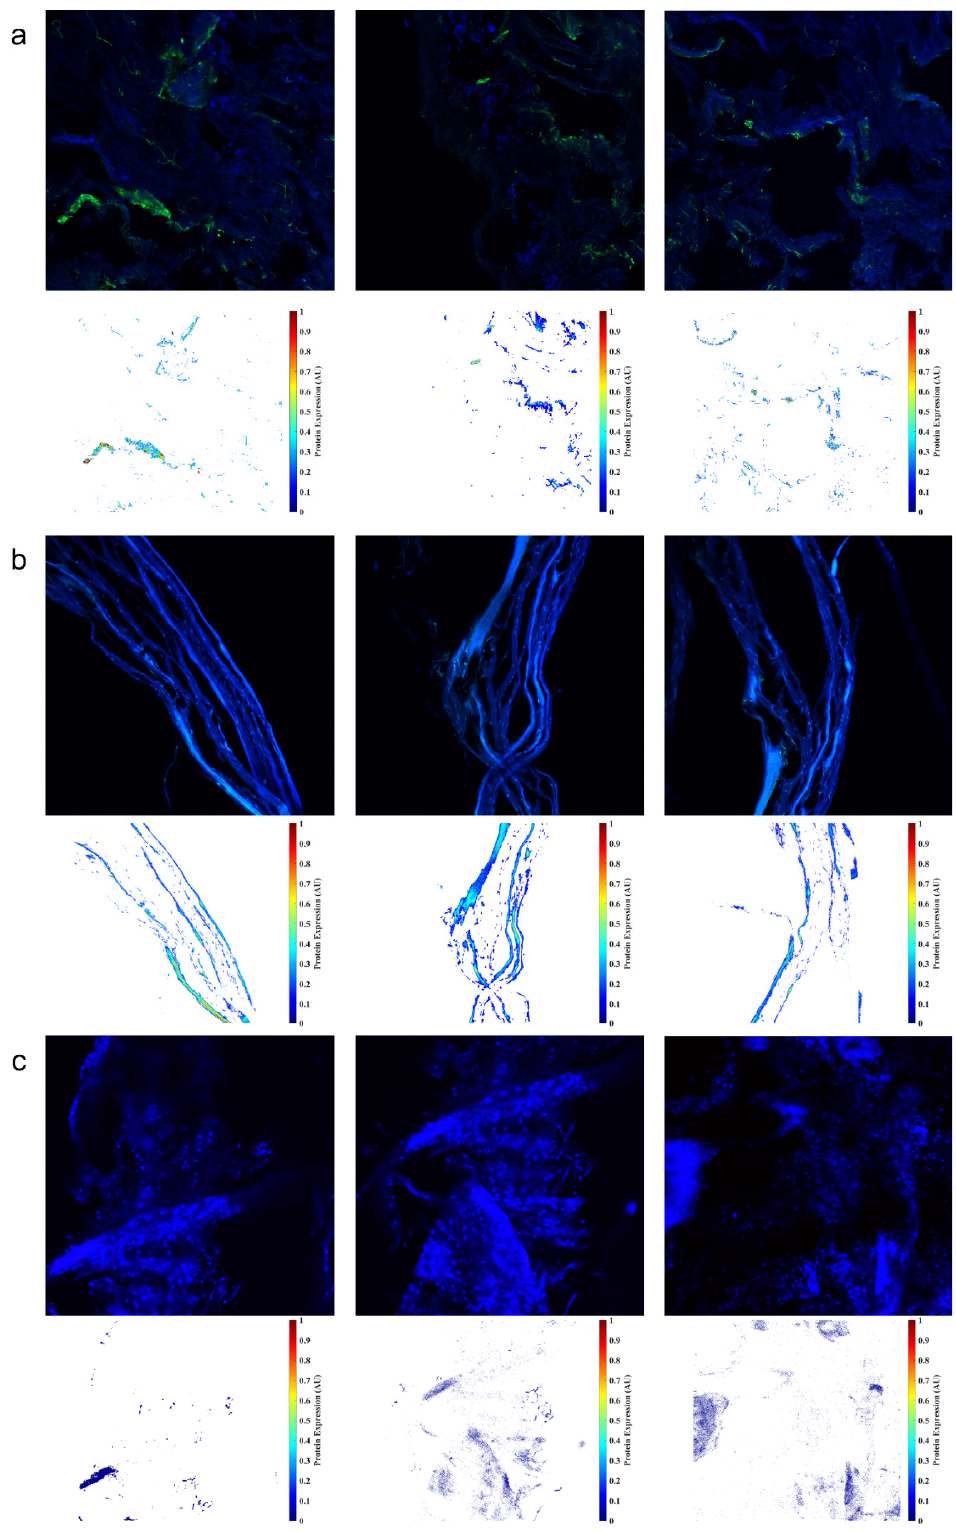
Figure 3. Elastin immunofluorescent imaging and spatial intensity mapping for: ( a ) seeding hBMM- SCs onto PSIS bio-scaffold substrates, rotisserie cultured for 8 days followed by an additional 14 days of oscillatory flow conditioning (TAWSS of 3.1 dynes/cm 2 and an OSI of 0.20), ( b ) seeding hBMMSCs onto PSIS bio-scaffold substrates and then statically (rotisserie) cultured for 22 days, and ( c ) the raw PSIS